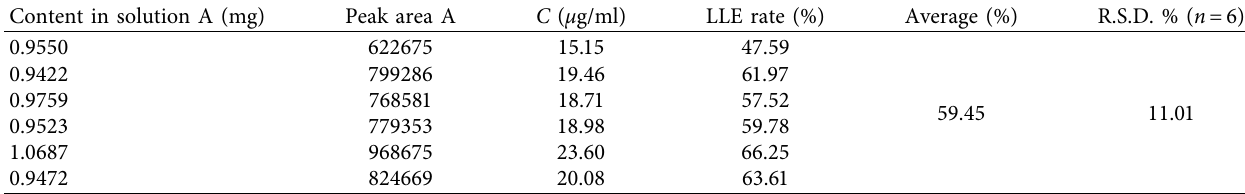
Table 6: Results of liquid-liquid extaction rate.